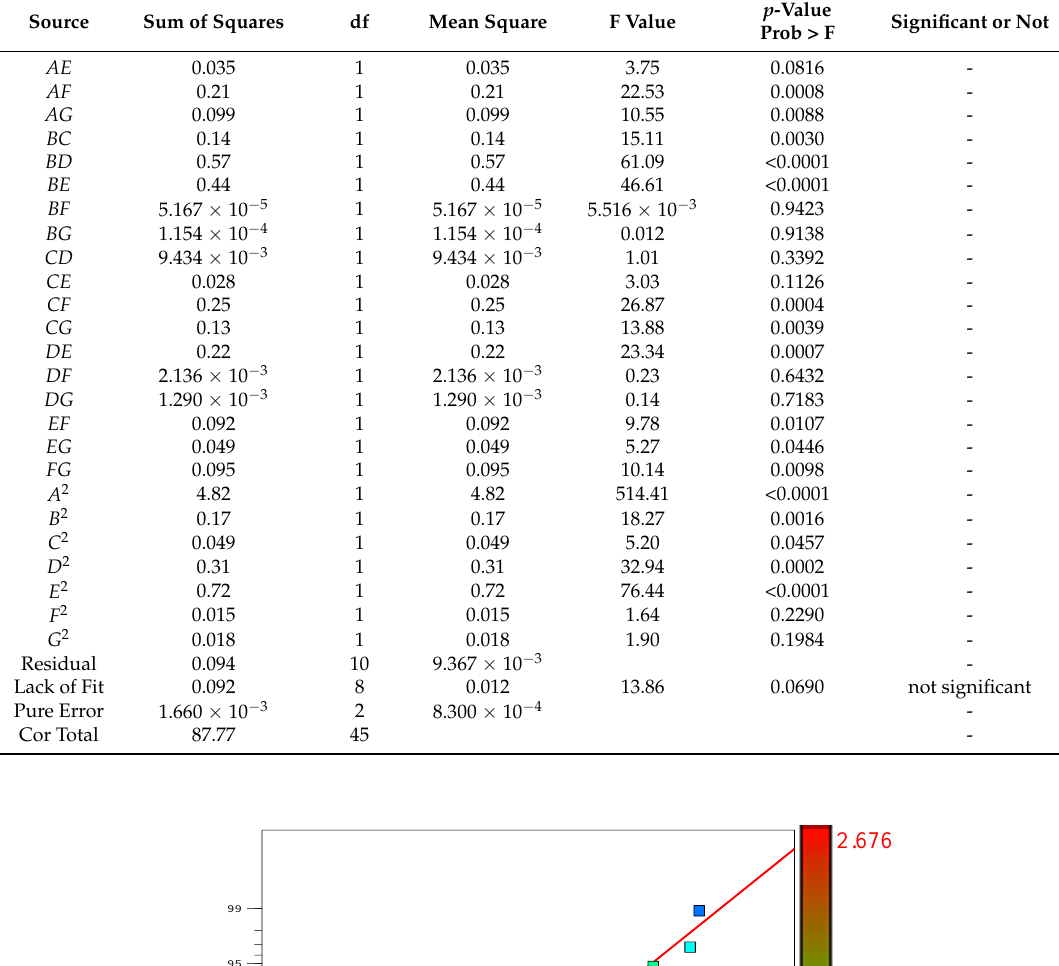
Normal Plot of Residuals